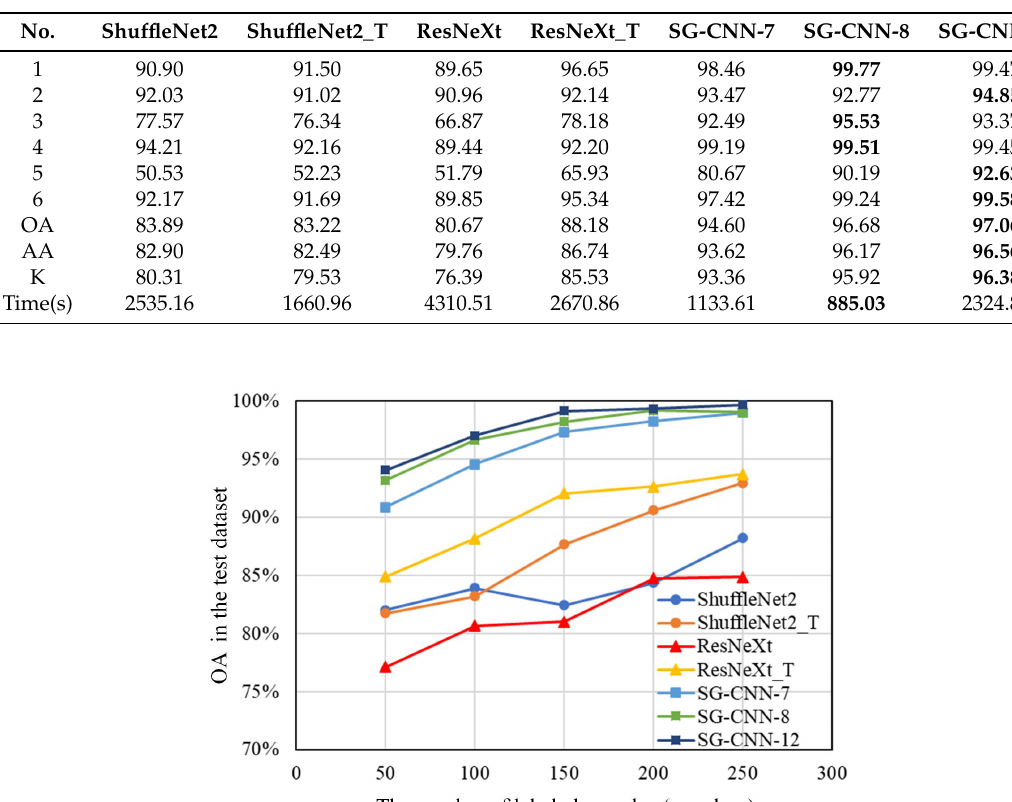
Table 8. Classification accuracy (%) and computation time of the DC Mall scene. A total of 600 labeled samples (100 per class) were used for fine-tuning. The No. column refers to the corresponding class in Table 7. The best results are in bold .